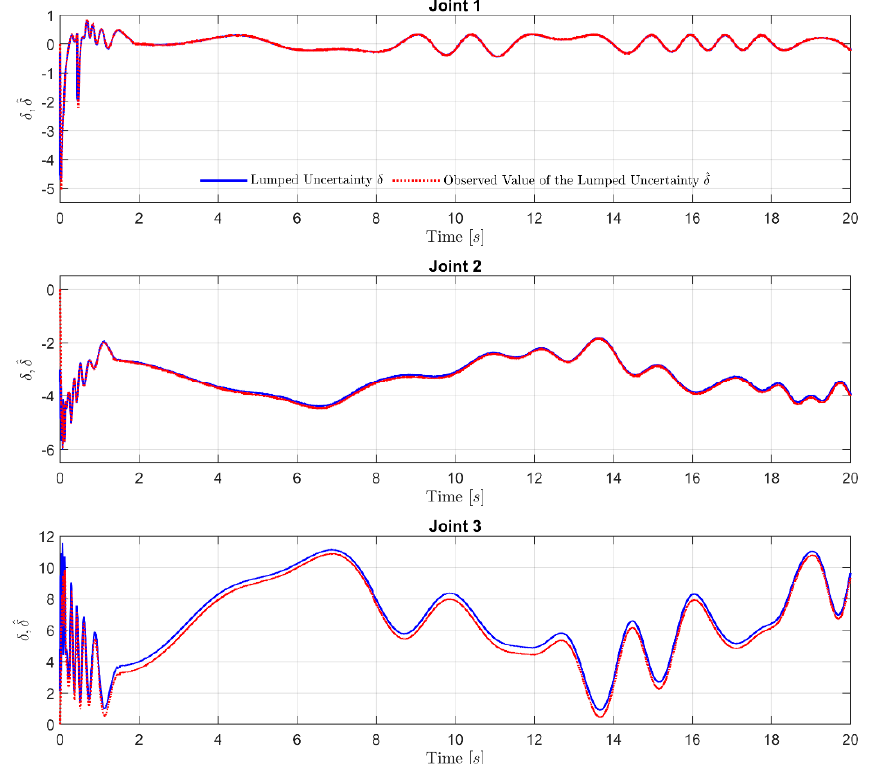
Figure 4. Supposed value of the lumped uncertainty and observed value of the lumped uncertainty at each Joint.